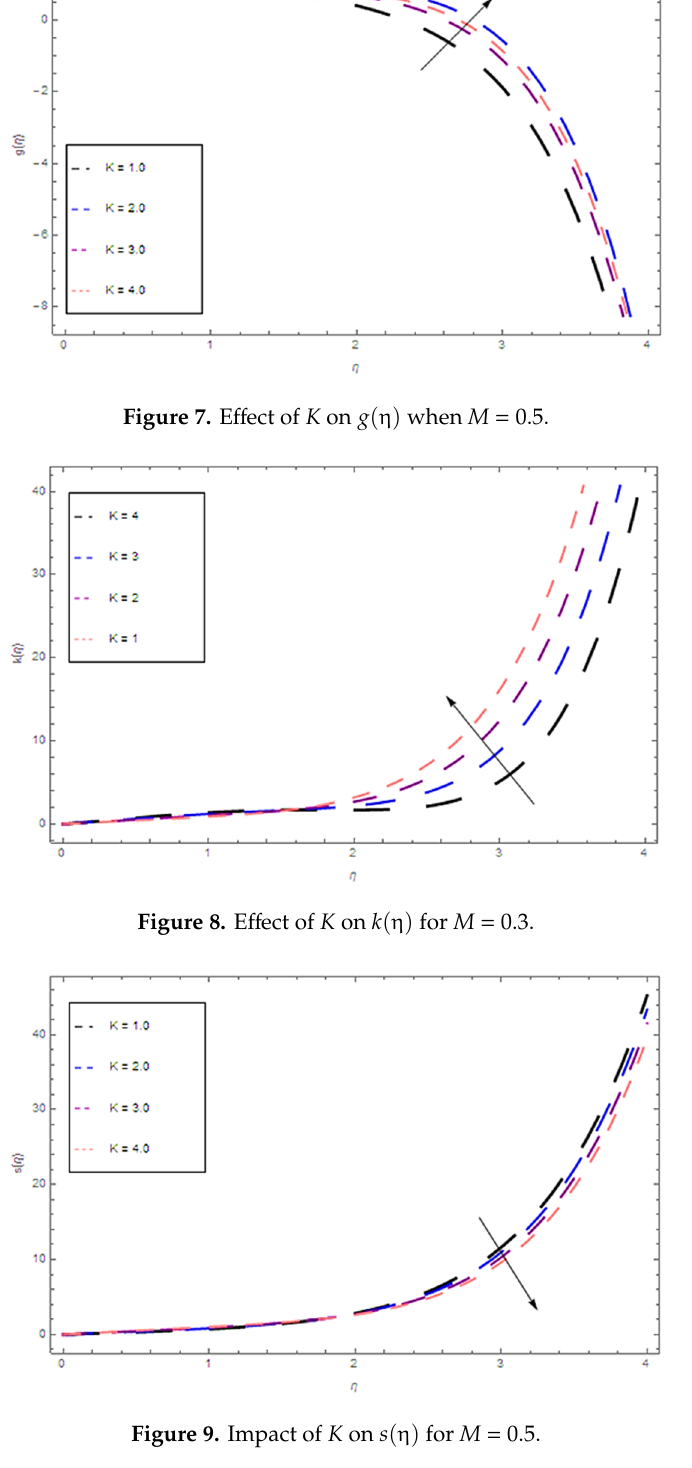
Figure 9. Impact of K on s ( η ) for M = 0.5.